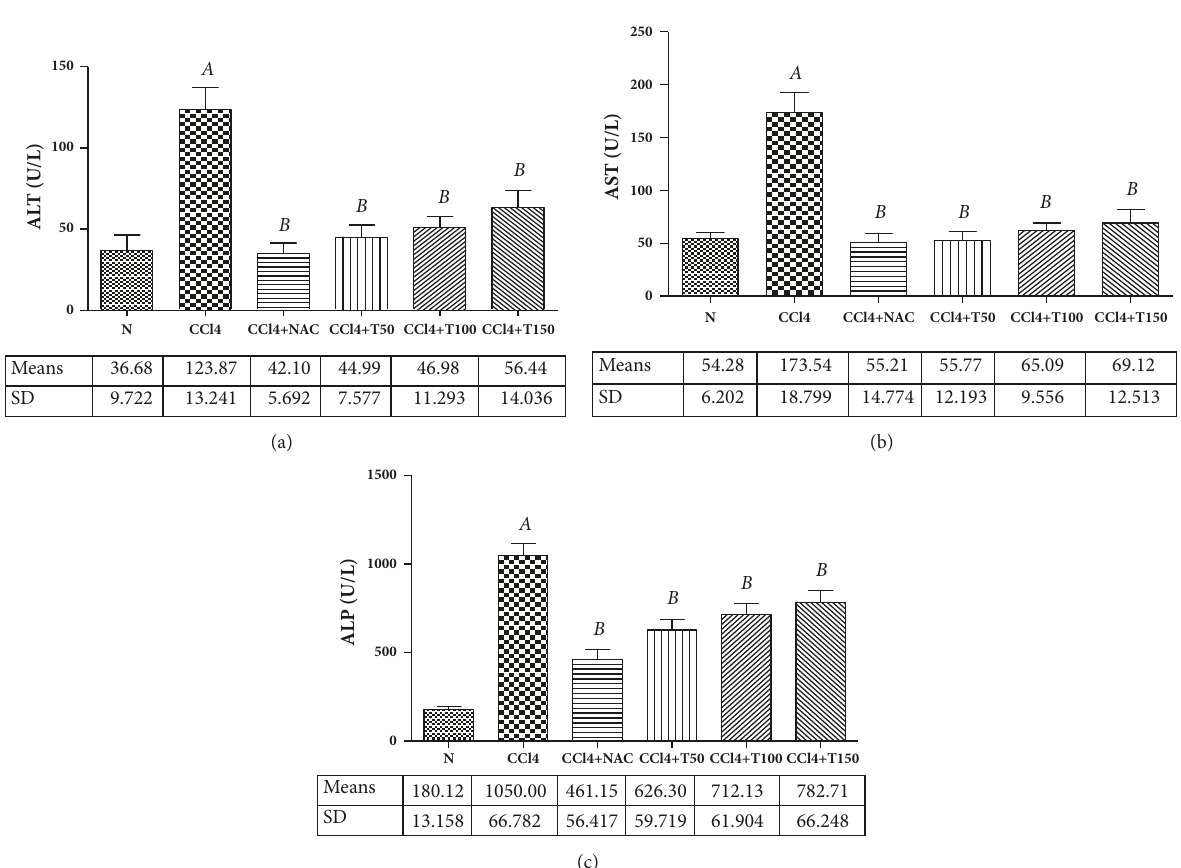
Figure1: (a)PlasmaALTlevelsofnormalcontrol,CCl 4 ,CCl 4+ NAC150,CCl 4+ T50,CCl 4+ T100,andCCl 4+ T150groups. Datarepresentthemeans ± SD (n=5). N: normal, CCl 4 : carbon tetrachloride,NAC:N-acetylcysteine150 mg/kg body weight/day,and T50, T100, and T150: Proliverenol 50, 100, and 150 mg/kg body weight/day. A = p < 0.05 vs. N, B = p < 0.05 vs. CCl 4 ( 𝛼 =0.05). (b) Plasma AST levels of normal control, CCl 4 , CCl 4+ NAC150, CCl 4+ T50, CCl 4+ T100, and CCl 4+ T150 groups. Data represent the means ± SD (n=5). N: normal, CCl 4 : carbon tetrachloride, NAC: N-acetylcysteine 150 mg/kg body weight/day, and T50, T100, and T150: Proliverenol 50, 100, and 150 mg/kg body weight/day. A = p < 0.05 vs. N, B = p < 0.05 vs. CCl 4 ( 𝛼 =0.05). (c) Plasma ALP levels of normal control, CCl 4 , CCl 4+ NAC150, CCl 4+ T50, CCl 4+ T100, and CCl 4+ T150 groups. Data represent the means ± SD (n=5). N: normal, CCl 4 : carbon tetrachloride, NAC: N-acetylcysteine150 mg/kg body weight/day, and T50, T100, and T150: Proliverenol 50, 100, and 150 mg/kg body weight/day. A = p < 0.05 vs. N, B = p < 0.05 vs. CCl 4 ( 𝛼